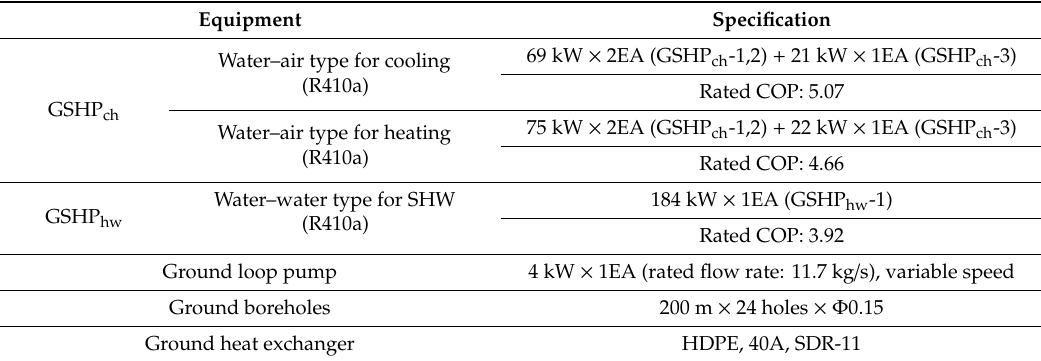
Table 1. Specification of the integrated geothermal system.